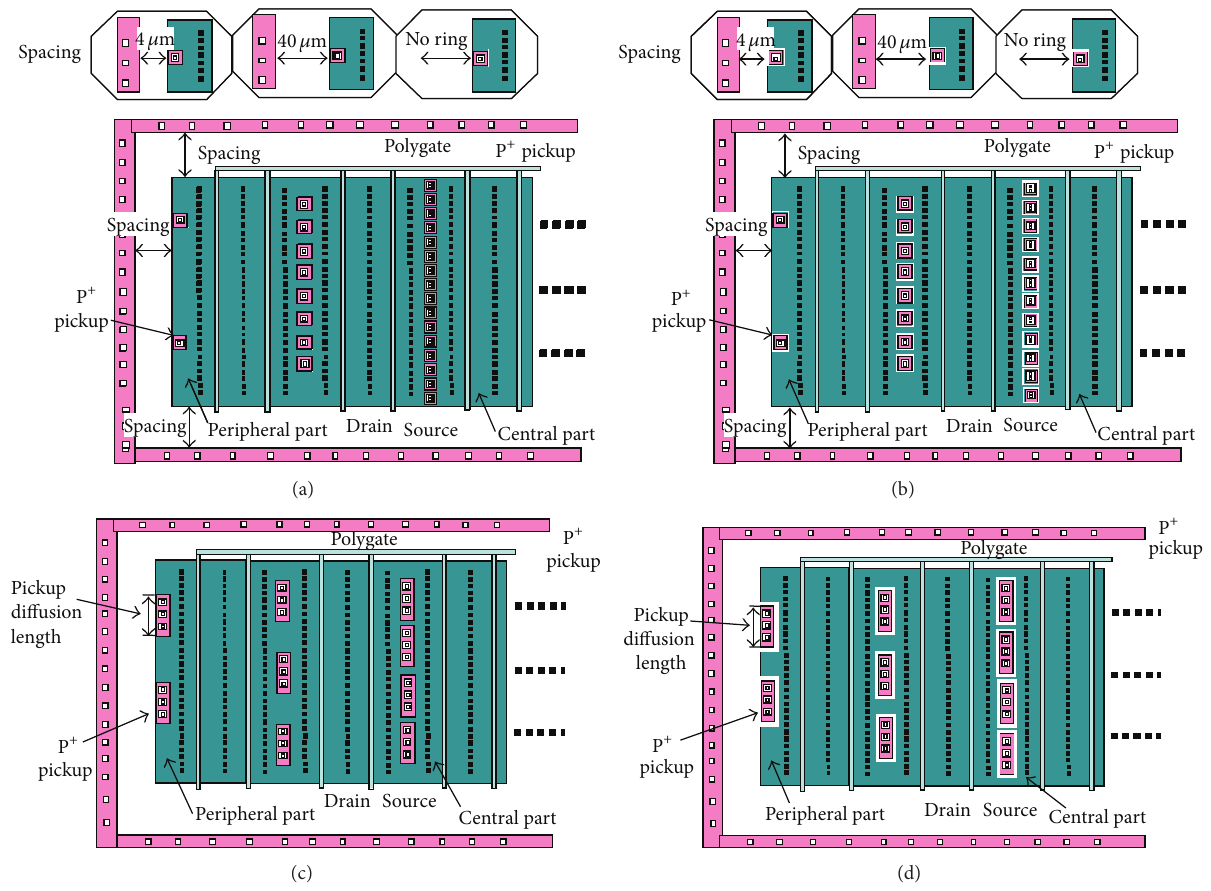
Figure 2: (a) The proposed split island layout of the butting substrate pickups for the multifinger NMOS devices. (b) The proposed split island layout of the inserted substrate pickups for the multifinger NMOS devices. (c) The proposed split island layout diagram of the butting substrate pickups with varied pickup length for the multifinger NMOS devices. (d) The proposed split island layout diagram of the inserted substrate pickups with varied pickup length for the multifinger NMOS